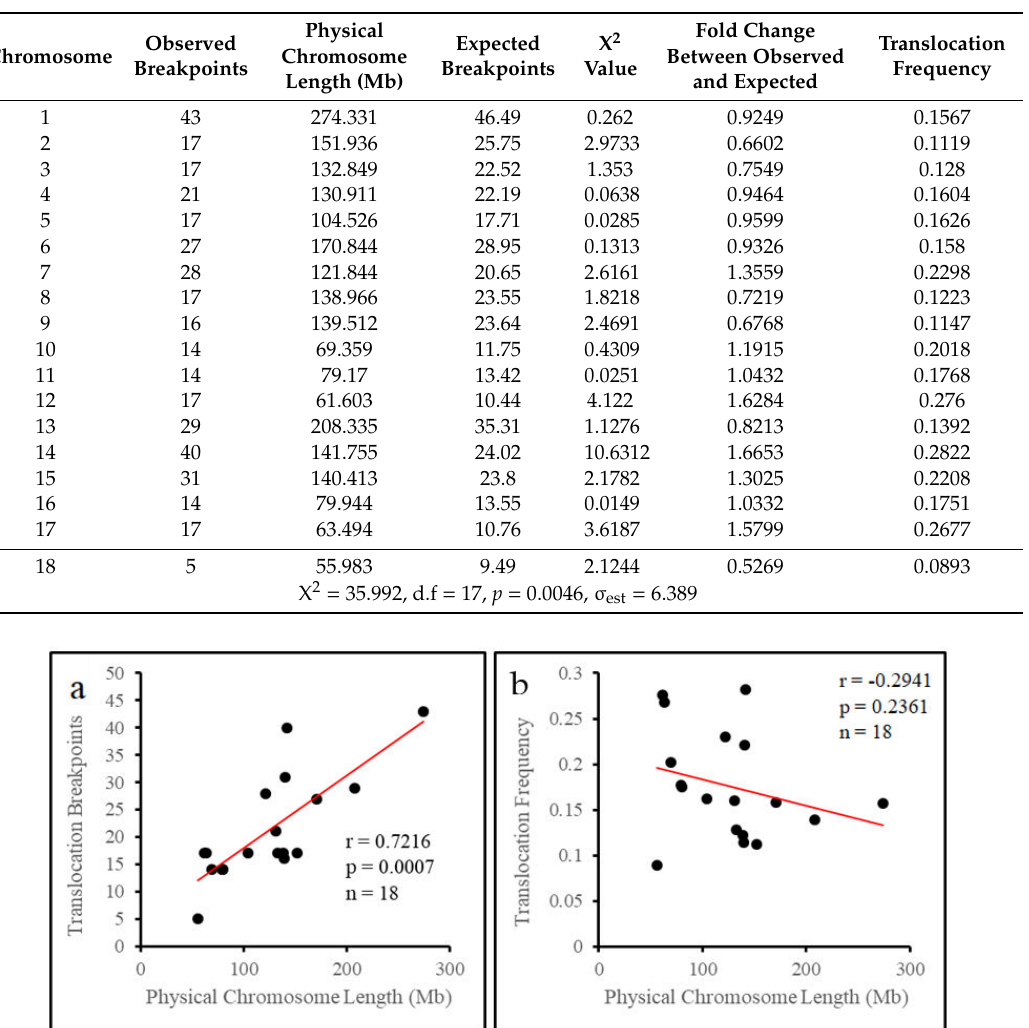
Table 1. Distribution of translocation breakpoints across chromosomes.